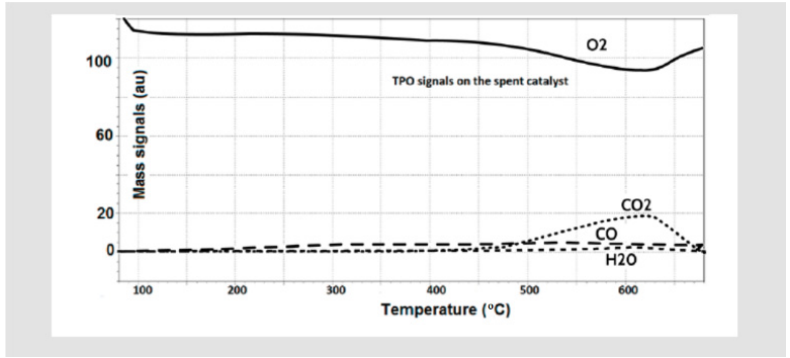
Figure 12. TPO profile on the fresh catalyst. Figure 10. TPO spectrum on the spent catalyst.